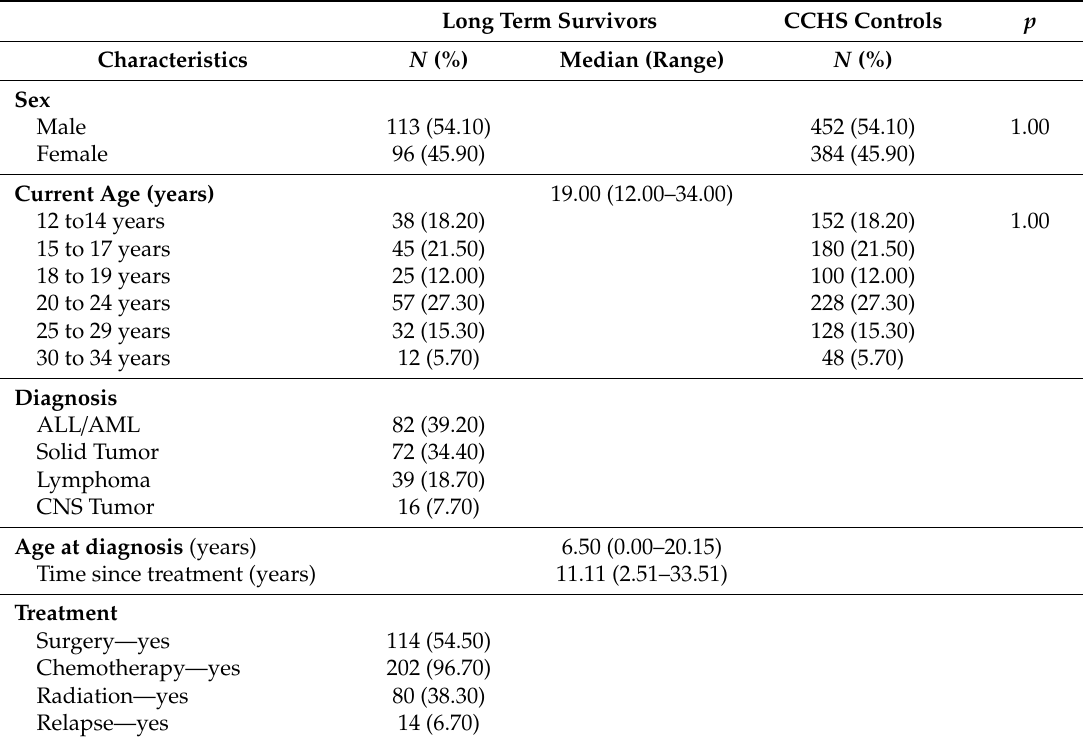
Table 1. Descriptive characteristics of